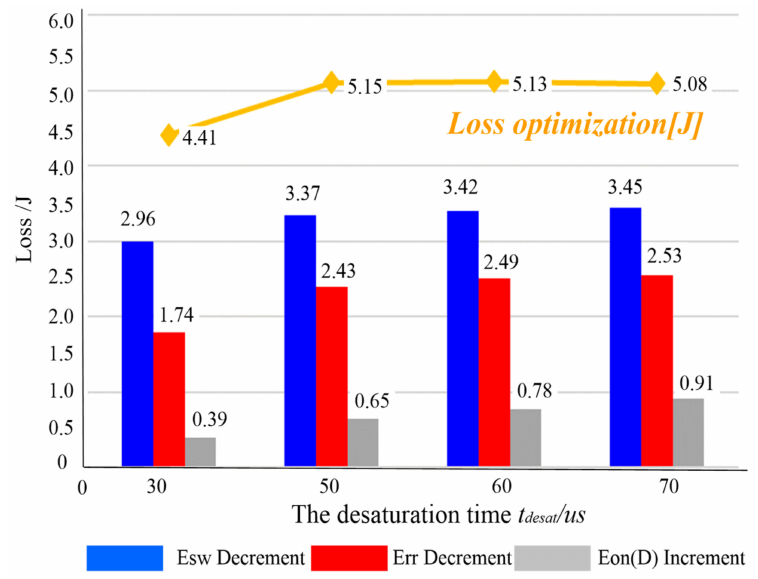
Figure 12. Loss comparison between RC-IGBT and conventional IGBT under 3500 V/1000 A.